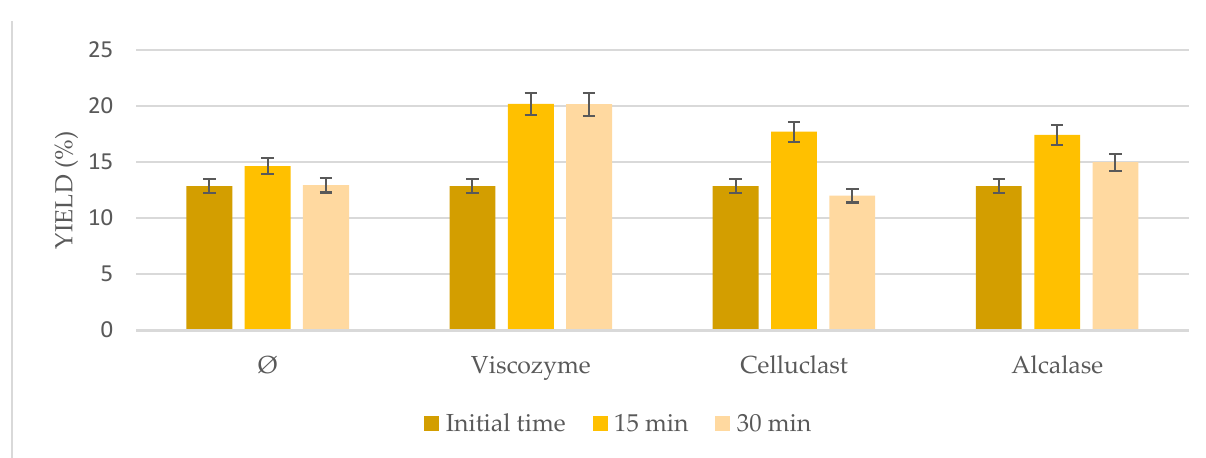
Figure 3. Oil yield obtained from high-intensity sonication at 4 °C combined with enzymatic pretreatment using Nanno- chloropsis gaditana compared to not pretreated biomass (Ø ) under the same conditions.